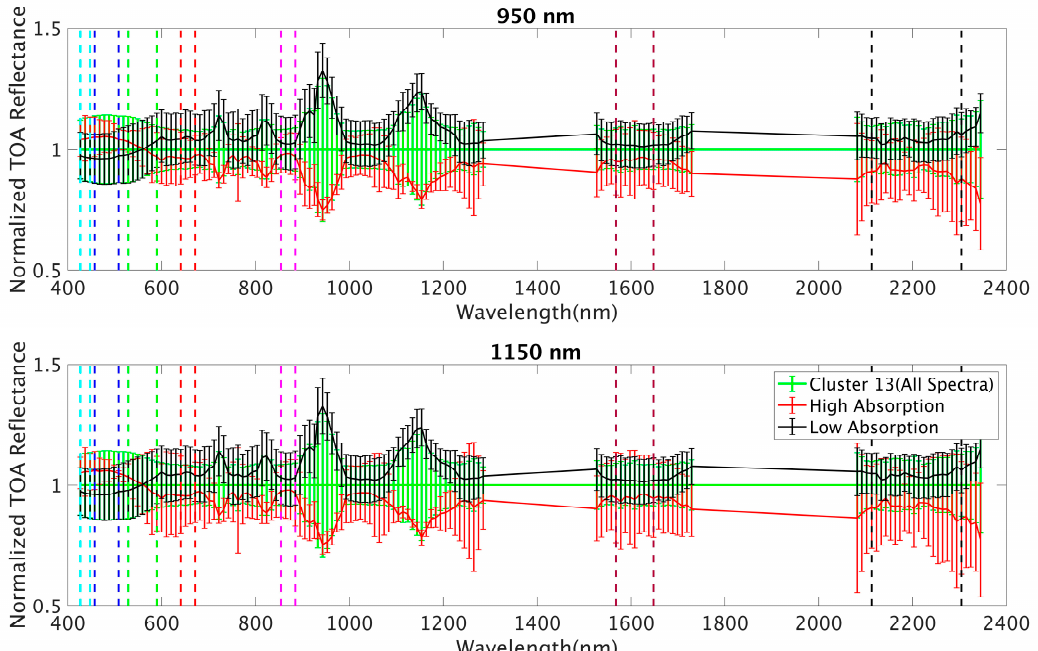
Figure 12. Comparison of a representative hyperspectral profile of Cluster 13 and hyperspectral measurements having different water vapor content. The green curve represents the normalized hyperspectral profile of Cluster 13. The red curve represents the hyperspectral measurement corresponds to higher water vapor content whereas the black curve represents the hyperspectral measurement corresponding to lower water vapor content. (Error bars = 2 sigma).